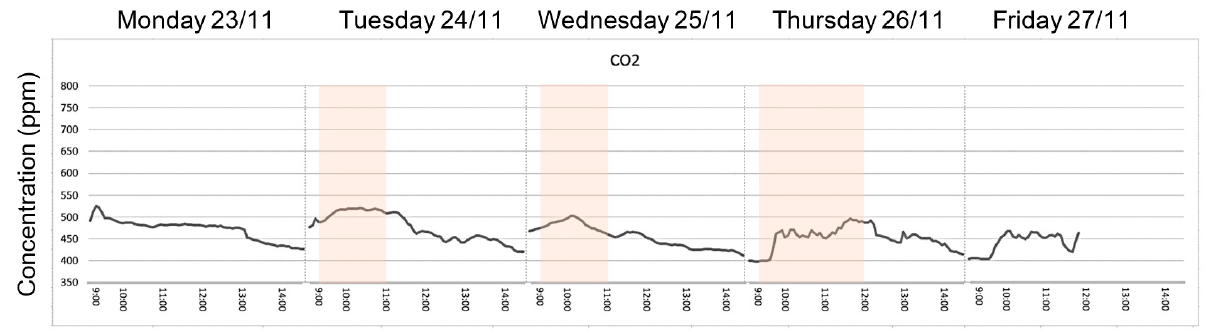
Figure 10. Verification of the ventilation conditions through CO 2 concentration measurement.